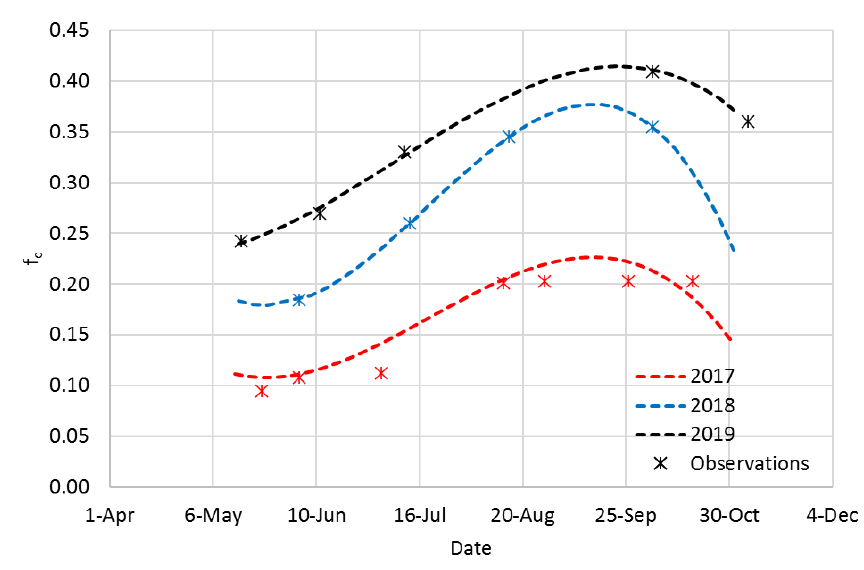
Figure 2. Evolution of the modeled vegetation fractional cover, f c , during the 2017–2019 experiments (lines) superposed to the field measurements (marks).